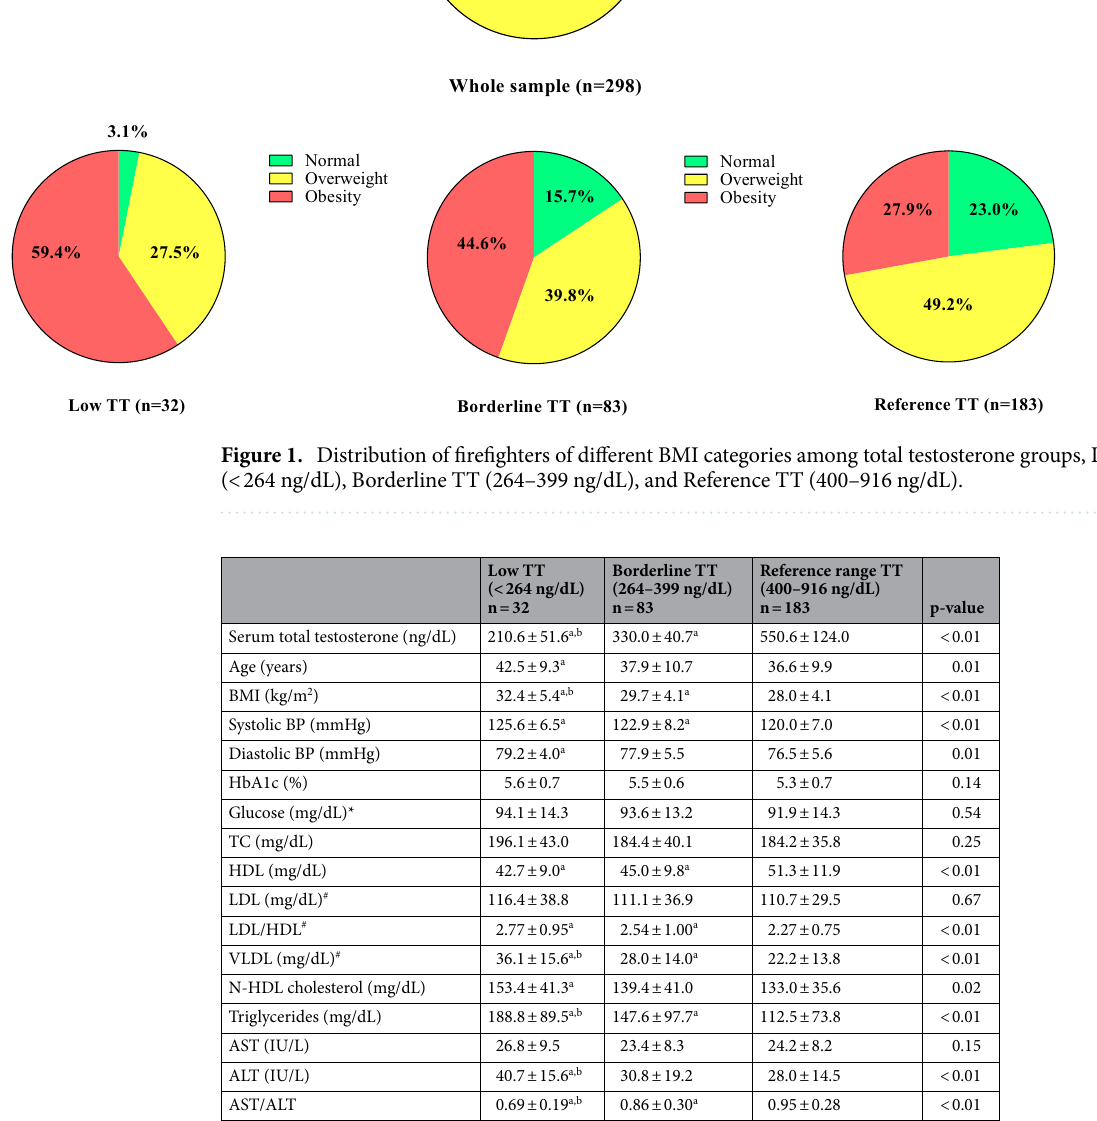
After adjusting for confounding variables, the odds of having fatty liver was almost fourfold higher for the low-TT group as compared to the reference TT group (Table 4). The reverse analysis also showed a strong